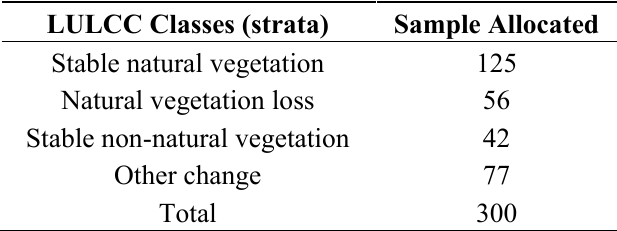
Table 8. Sample size allocated to each LULCC